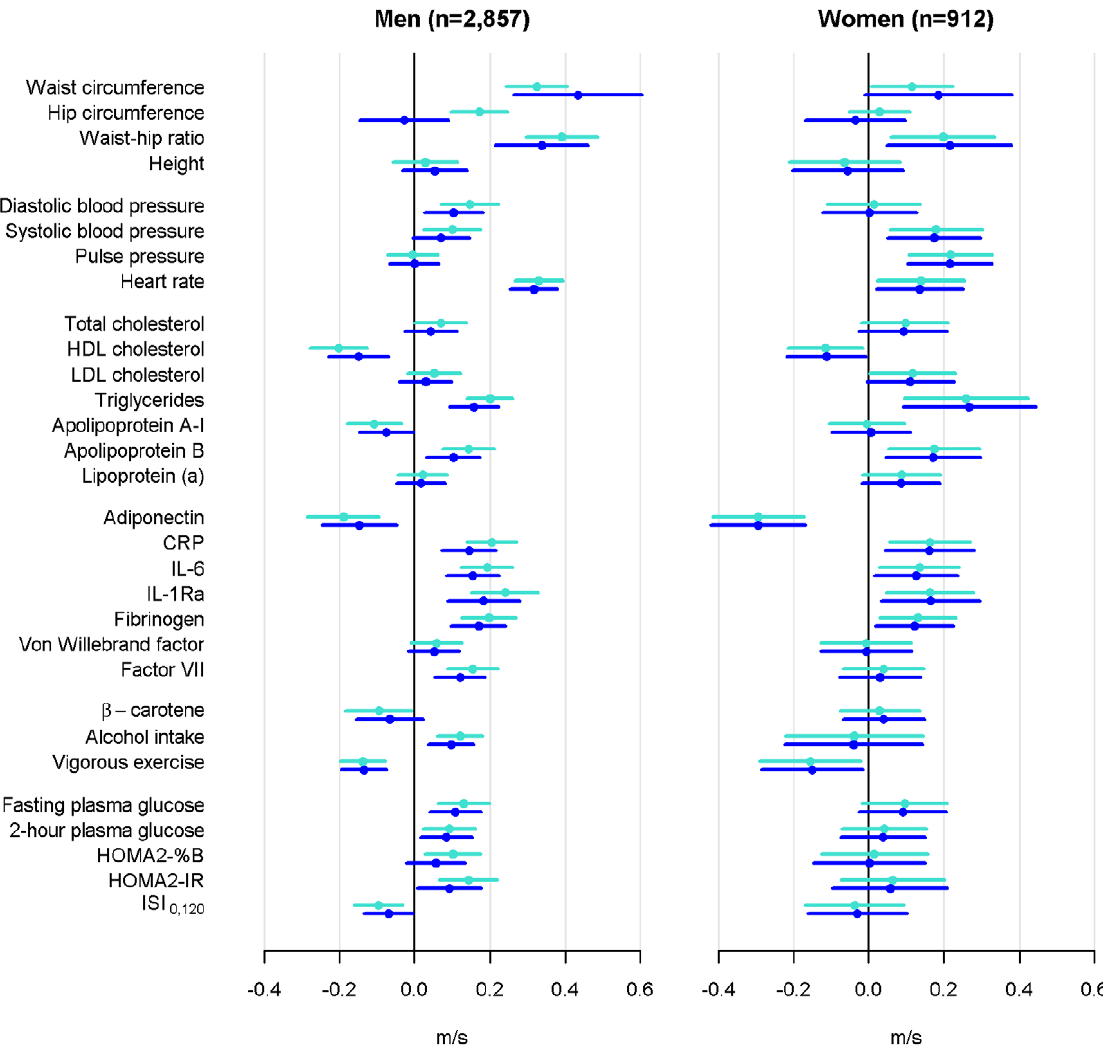
Figure 1. Standardized regression coefficients for predicting aortic pulse wave velocity. Light blue: adjustment for age, quadratic age, mean arterial pressure at the time of aortic pulse wave velocity measurement, and for relevant treatment and event history. Dark blue: further adjustment for body mass index. HDL=high density lipoprotein; LDL=low density lipoprotein; CRP=C-reactive protein; IL-6=interleukin 6; IL- 1Ra=interleukin 1 receptor antagonist; HOMA2-%B= b -cell function; HOMA2-IR=insulin resistance; ISI 0–120 =insulin sensitivity index.